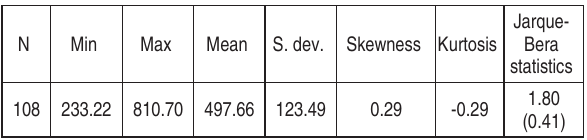
Table 2. Descriptive statistics and normality test ( p -value in brackets) of the summer rainfall data for